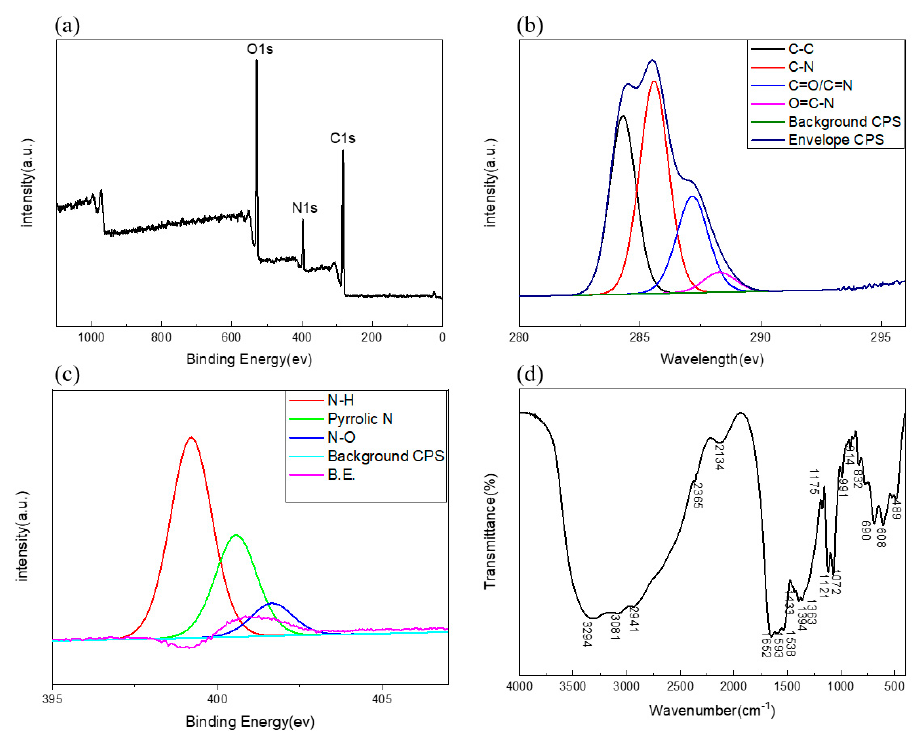
Figure 2. ( a ) The full-scale XPS spectrum of C / N-dots. High-resolution C1s ( b ) N1s ( c ) XPS spectra of C / N-dots. ( d ) FTIR spectrum of C / N-dots.